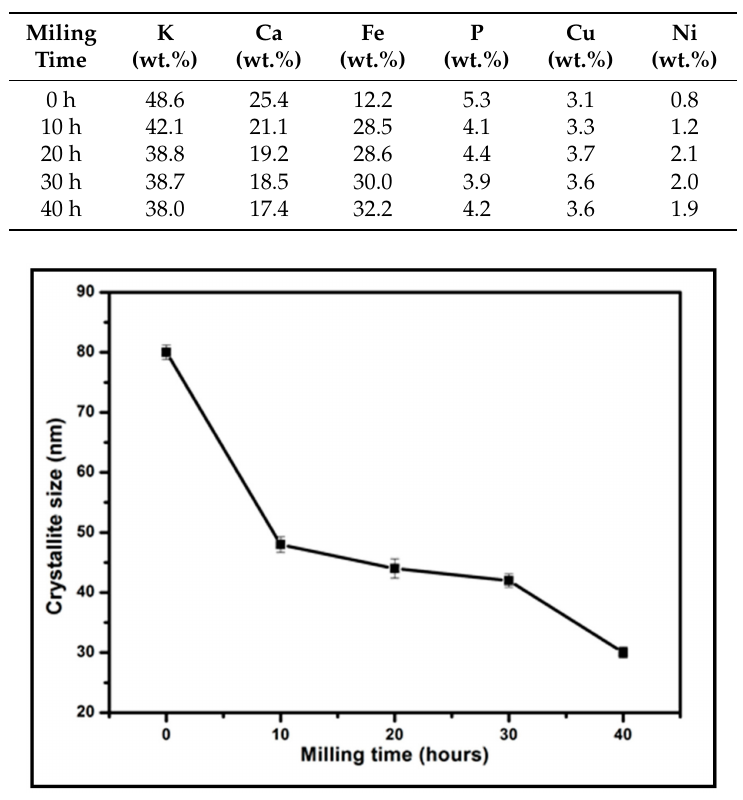
Figure 3. Crystallite size of coconut shell particles (with nano before milling at